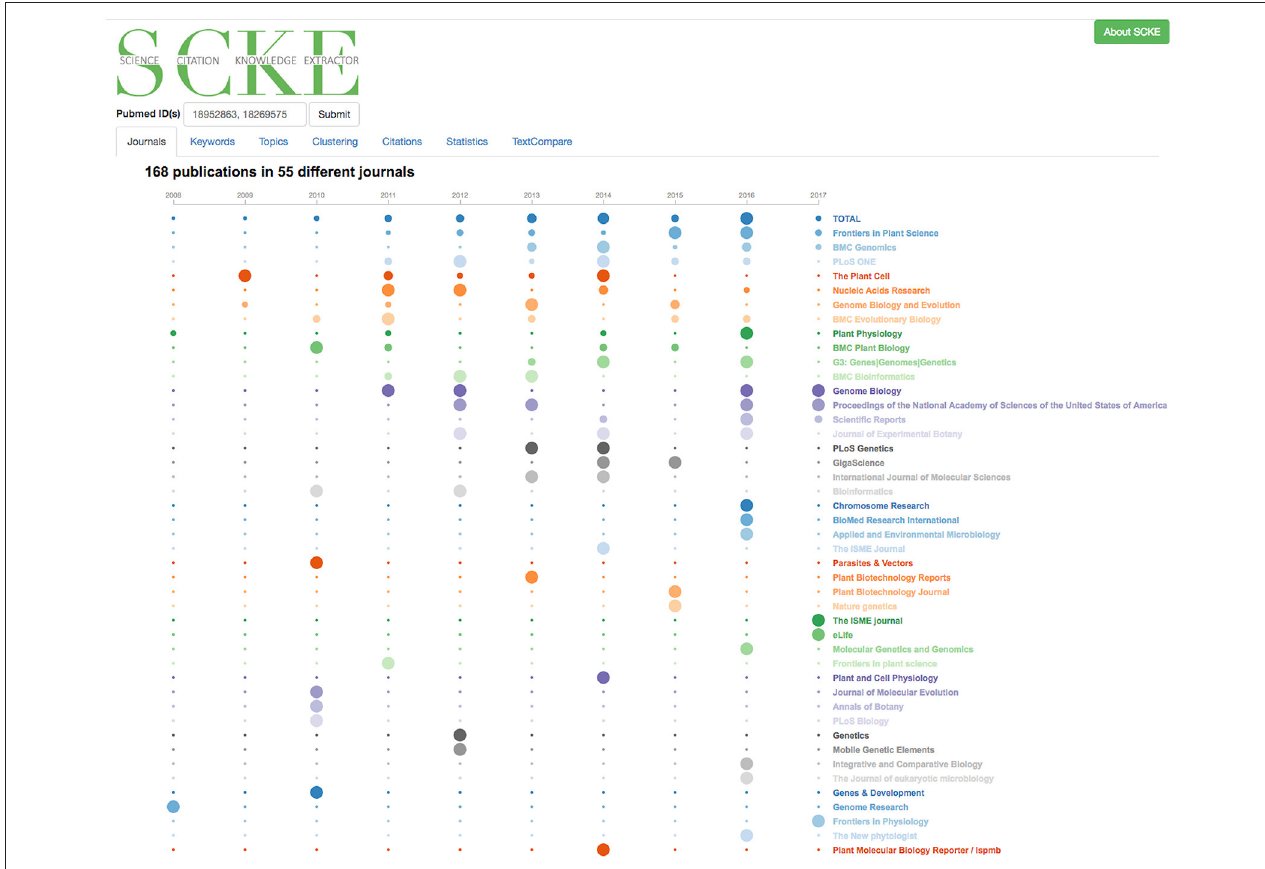
FIGURE 6 | Visualizing Citations by Journal of Publication and by year. This interactive data visualization displays the counts for the number of citations per year when users use the mouse to hover over the journal name. To regenerate this analysis, visit